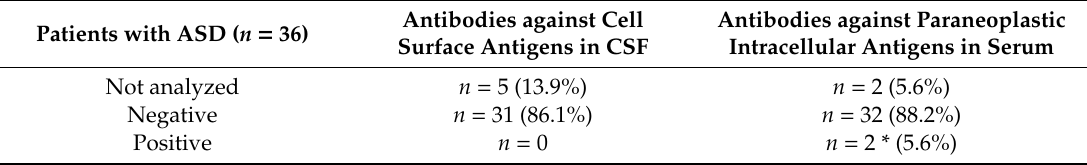
Table 5. Antineuronal autoantibody findings.